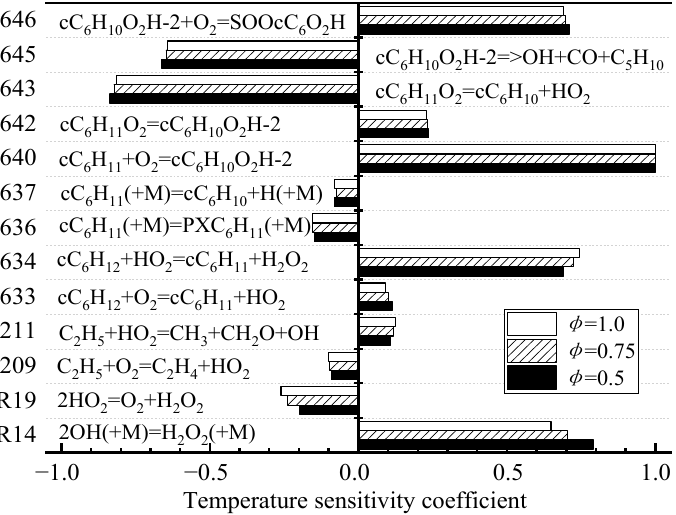
Figure 5. Temperature SA of different equivalence ratios (T = 1000 K, p = 2 MPa). In this part of the work, the generation rate analysis retains the elementary reactions with a larger reaction rate in the framework mechanism. It also removes the elementary reactions with a smaller reaction rate. So far, a simplified mechanism for CHX has been obtained, including 81 species and 280 elementary reactions (Supplementary Materials Text S1).